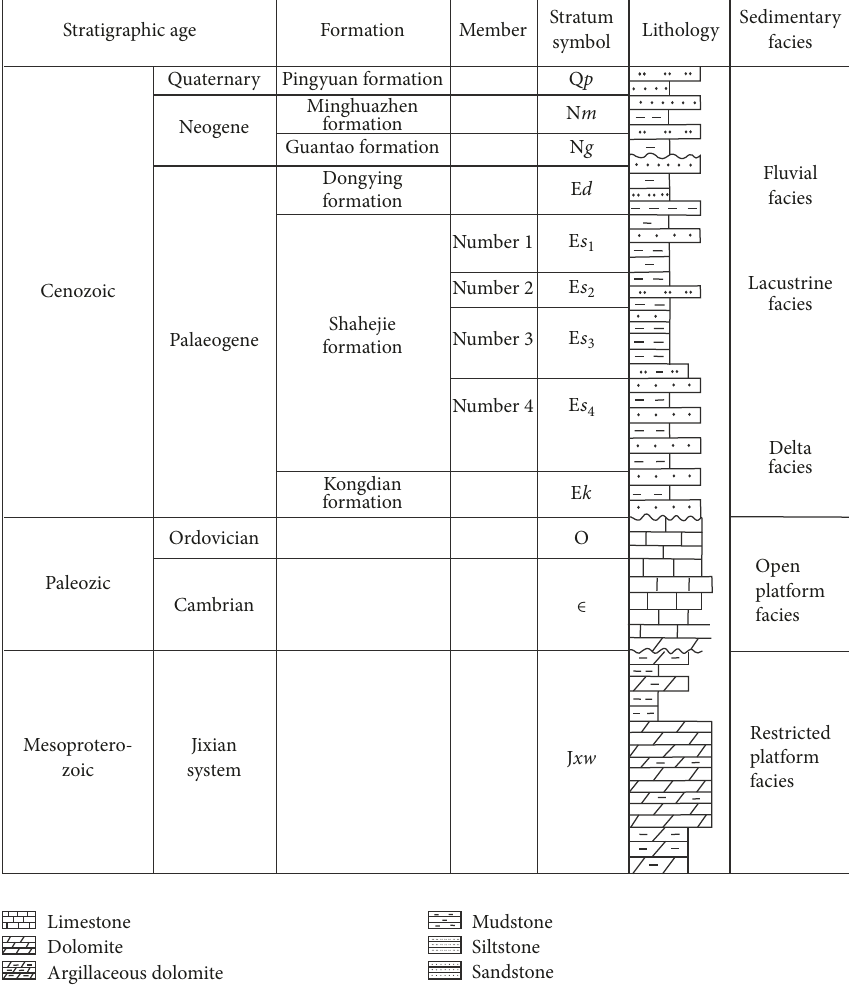
of grey mudstone and light grey sandstone interbedded with dolomite and gypsum, which is another important source rock. The Kongdian formation (Ek) includes varie- gated sandstone and red sandy mudstone, which gradually change upward into grey mudstone interbedded with gypsum mudstone